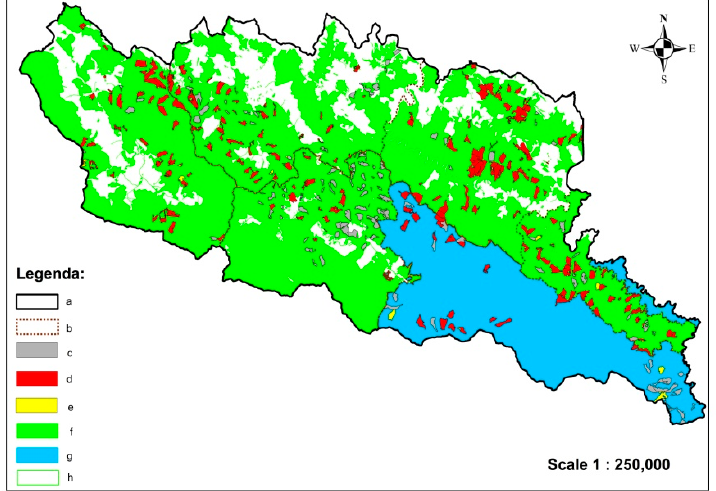
Figure 2. Distribution of study areas with Buxbaumia viridis : ( a ) boundaries of the study region, ( b ) boundaries of forest districts and the Bieszczady National Park (BNP), ( c ) surveyed areas without B. viridis , ( d ) selected study areas where B. viridis was found, ( e ) areas where B. viridis was found while moving to selected study areas, ( f ) land managed by forest districts, ( g ) BNP land, and ( h ) other forms of land ownership.